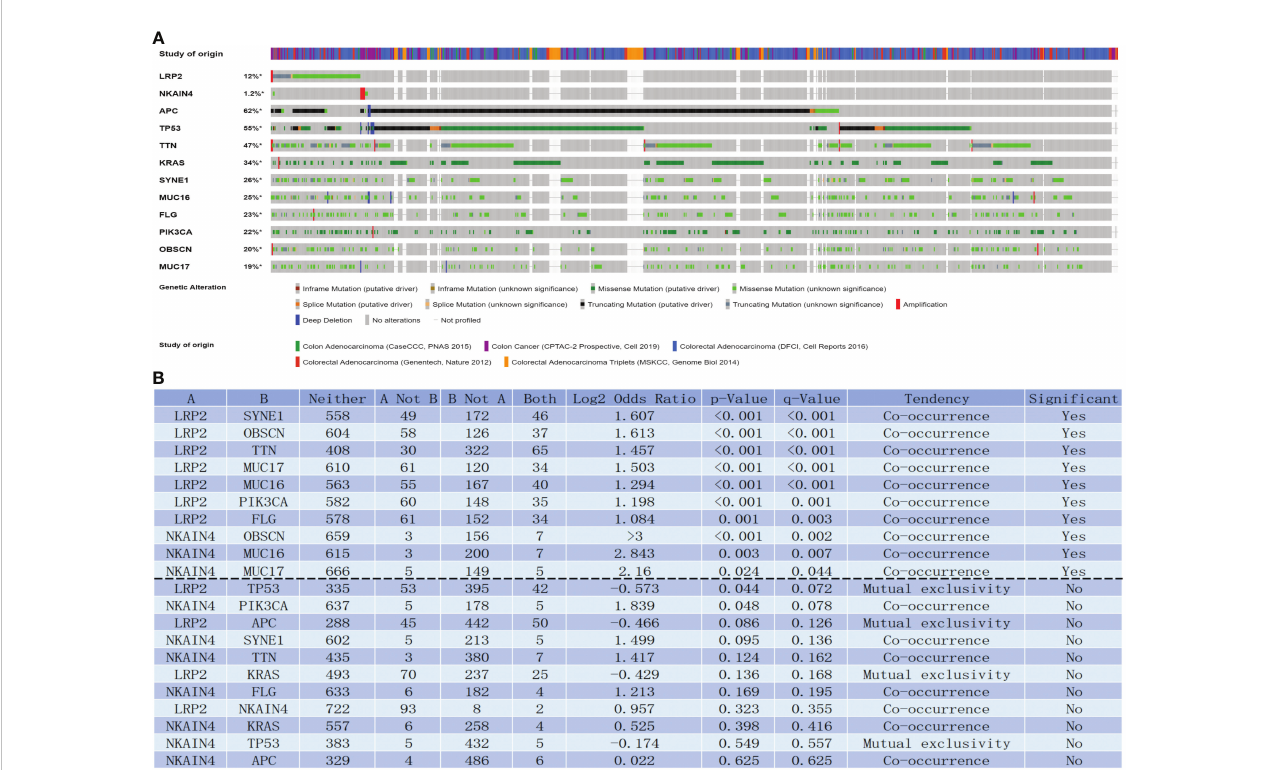
FIGURE 6 LNM-related genes with immune checkpoints in COAD. LNM-related genes and immune checkpoint alteration in COAD. Compact visualization of cases with multiple genetic alterations of LNM-related genes and immune checkpoints (origined from fi ve studies) were individually shown by cBioPortal as indicated, including fusion, ampli fi cation, deep deletion, truncating mutation, and missense mutation (A) . Mutual-exclusivity analysis between LNM- related genes and multiple-immune checkpoints in COAD. The altered relationship between LNM-related genes and each immune checkpoint, such as co-occurrence and mutual exclusivity, was presented as indicated (B) . The detailed log2 odds ratio, P-value, Q-value, tendency, and signi fi cance were individually presented in each panel. Q-value < 0.05 was considered to be statistically signi fi cant (indicated as yes, and others as no); LNM, lymph node metastasis; COAD, colon